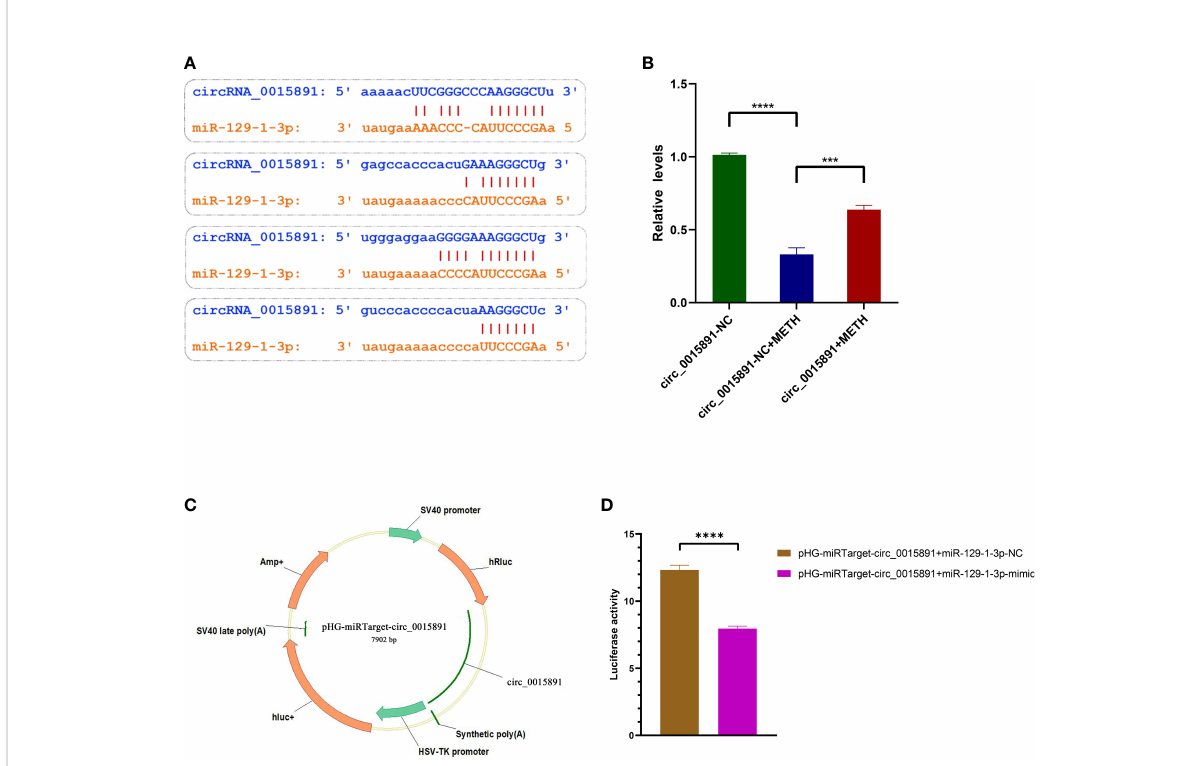
FIGURE 4 Identi fi cation and microRNA sponge validation of circ_0015891. (A) Base complementation prediction between circ_0015891 and miR-129-1- 3p. (B) Relative expression levels of circ_0015891 detected by RT-qPCR. (C) Schematic diagram of pHG-miRTarget-circ_0015891. (D) Luciferase activity in groups with different co-transfection pairings. Error bars represent the mean ± SEM.***P<0.001;